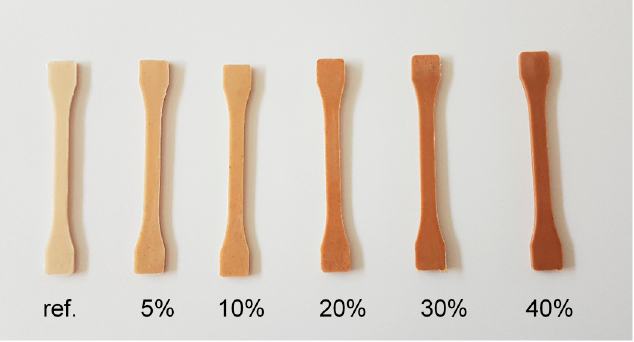
Figure 6. Biocomposite aspects with increasing filler content (from 0 to 40 wt %).